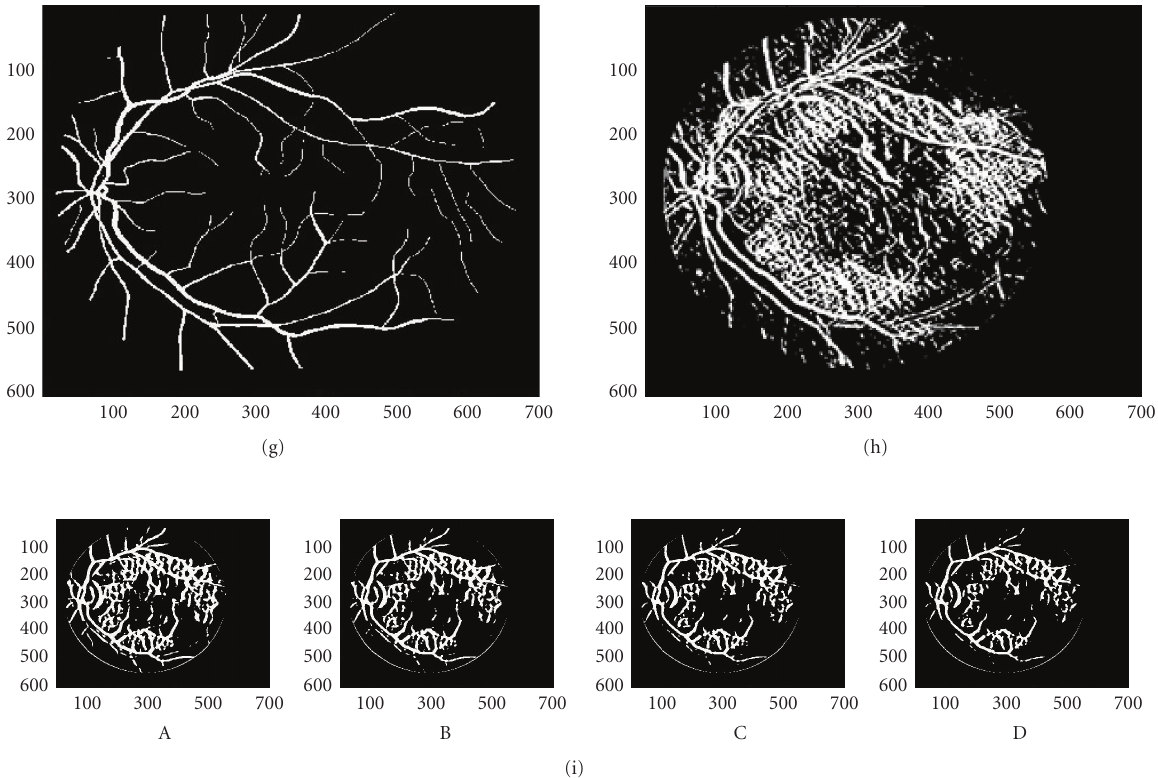
Figure 2: (a) Original fundus image with well traced major network and slightly distinct major peripheral network. (b) Original fundus image ellipse corrected. (c) Binary vessel wall map. (d) Vessel map based on VWP. (e) Retinal vasculature based on VWP and fine-segmented for local details. (f) Retinal vasculature without VWP map using MIP. (g) Estimated ground truth vessel vasculature. (h) Redundant vessel vasculature produced using an augmented VM and double-sided GS-MG. (i) 2nd vessel network: Successive maps taken using di ff erent features and di ff erent sensitivities ( thresholds ). (A) Gradient homogeneity VMs. (B) Paired VP map and dominant gradient VM. (C) Increased vessel width allowed, lower gradient threshold and interpolated WPs. (D) Experimentally proved